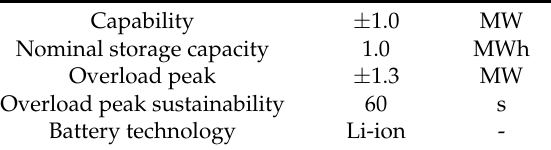
Table 5. Technical datasheet of EESS devoted to FCR in Codrongianos (Sardinia).